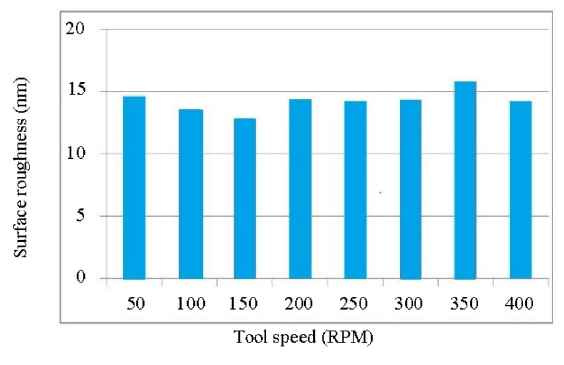
Fig. 11 Average surface roughness Ra values for all experiments.